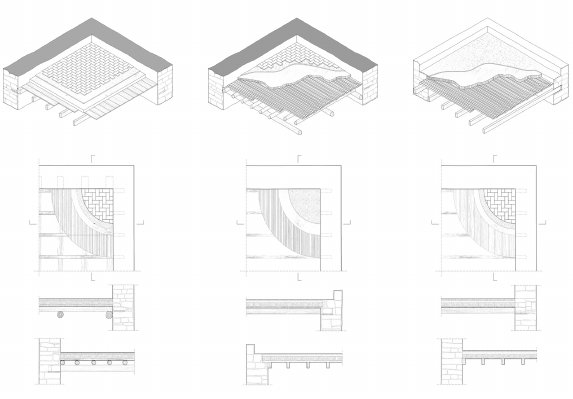
Figure 12. Constructive typologies for floors and